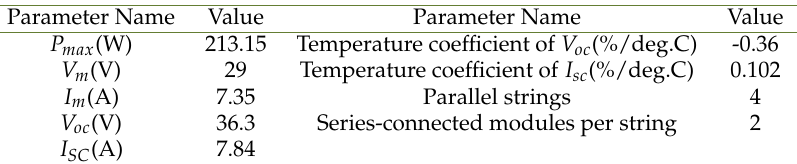
Table 1. PV module parameters under standard test conditions.